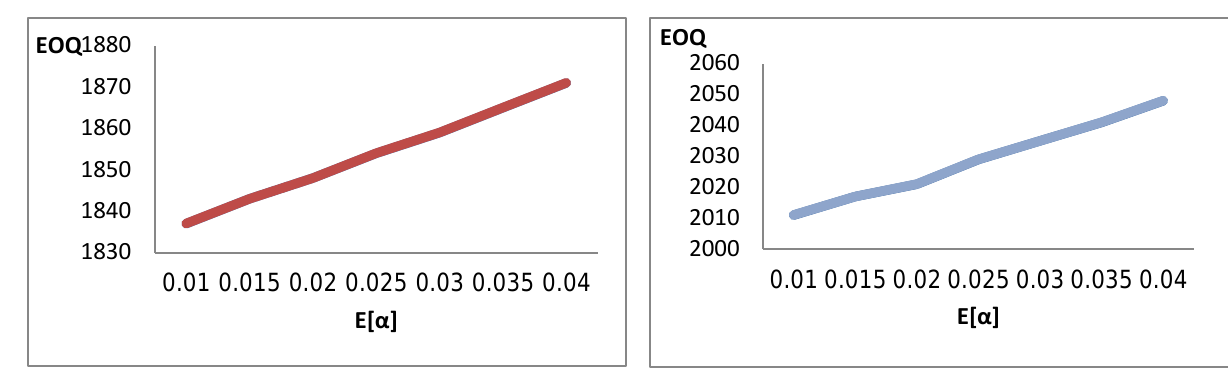
Fig. 5. Results summary of case 1 and case